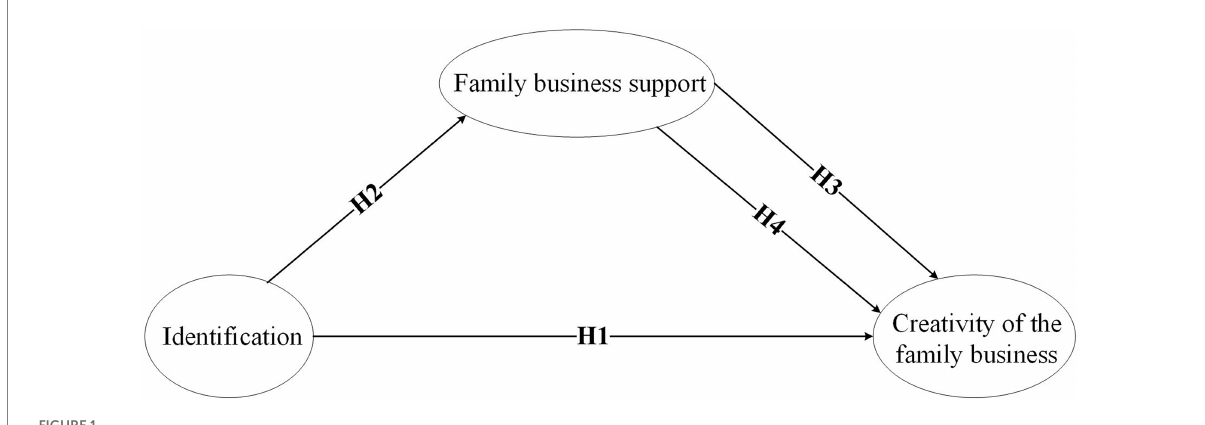
FIGURE 1 Research